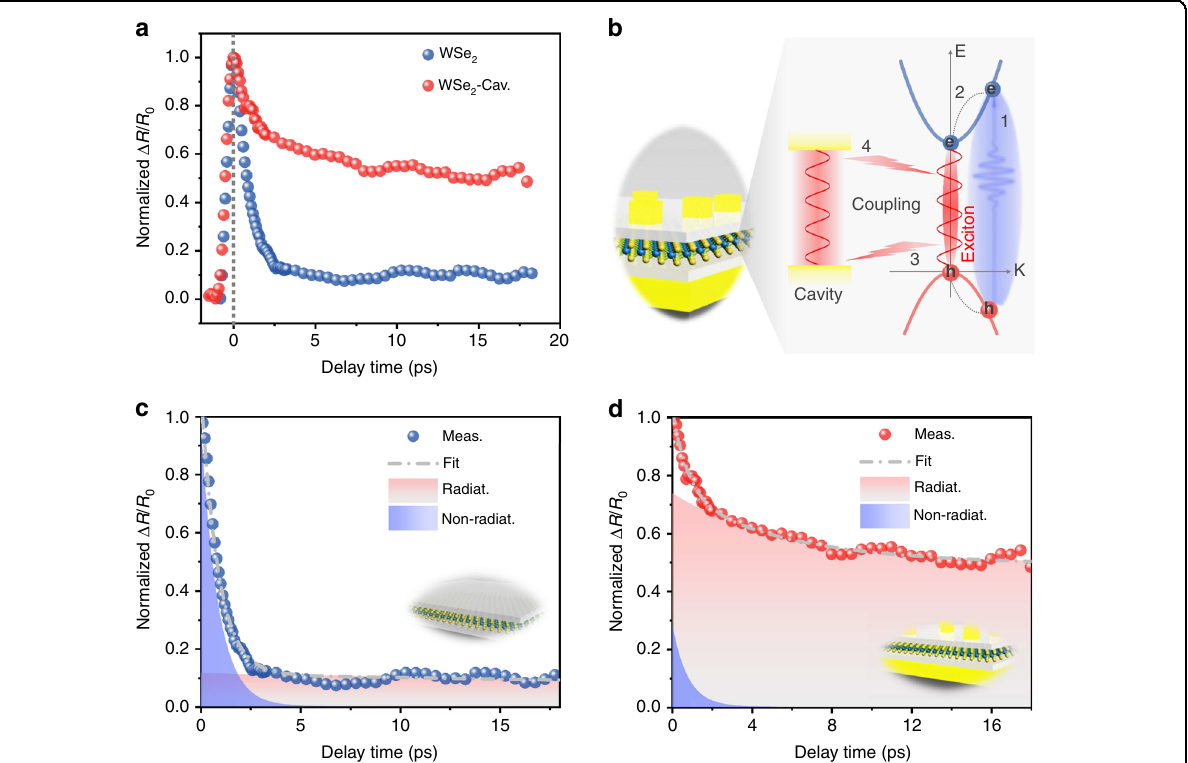
Fig. 5 Purcell effect modulated exciton relaxation in the plasmonic cavity. a Normalized differential re fl ection signal Δ R / R 0 for monolayer WSe 2 in free space and the plasmonic cavity. b Schematic diagram of the Purcell effect modulated exciton relaxation in the plasmonic cavity: 1. Nonresonant excitation, 2. intraband relaxation of energetic carriers, and 3 – 4. coupling between the cavity and exciton emission. c , d Fittings of the exciton relaxation in free space ( c ) and the plasmonic cavity ( d ). The regions fi lled with gradient red and blue colors represent the radiative and nonradiative contributions,